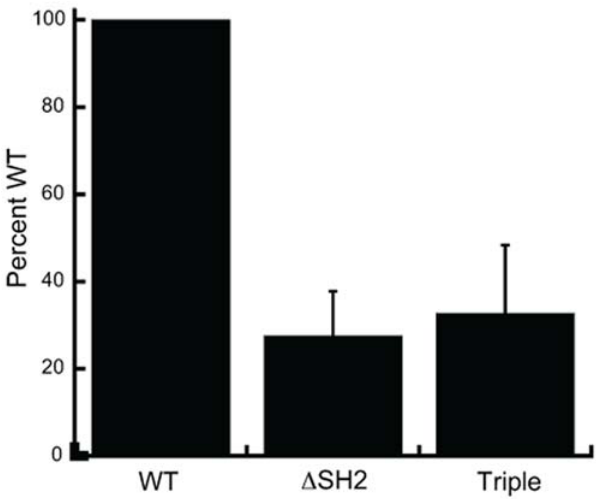
Figure 2. Kinase activity of triple mutant BCR-ABL is 40–50% that of wild type. 32D cells normalized for BCR-ABL expression were immunoprecipitated and kinase activity was assayed using a peptide substrate containing the consensus ABL kinase binding site. Assays were performed in triplicate for each cell line: wild type (WT), D SH2 and triple